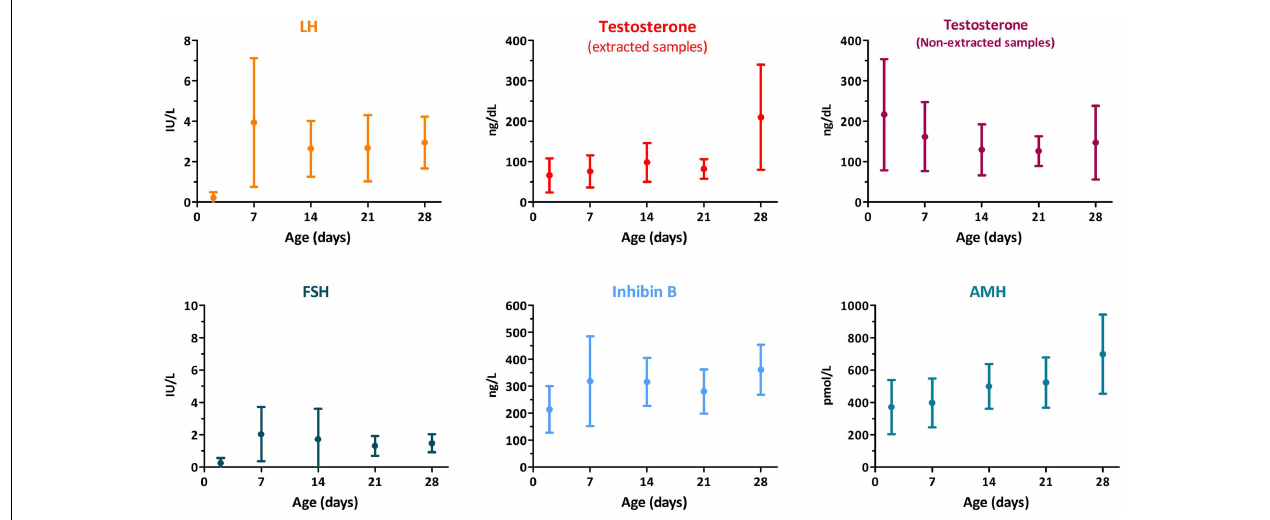
FIGURE 2 | Serum levels of gonadotropins and testicular hormones in male newborns . Data obtained from Ref.